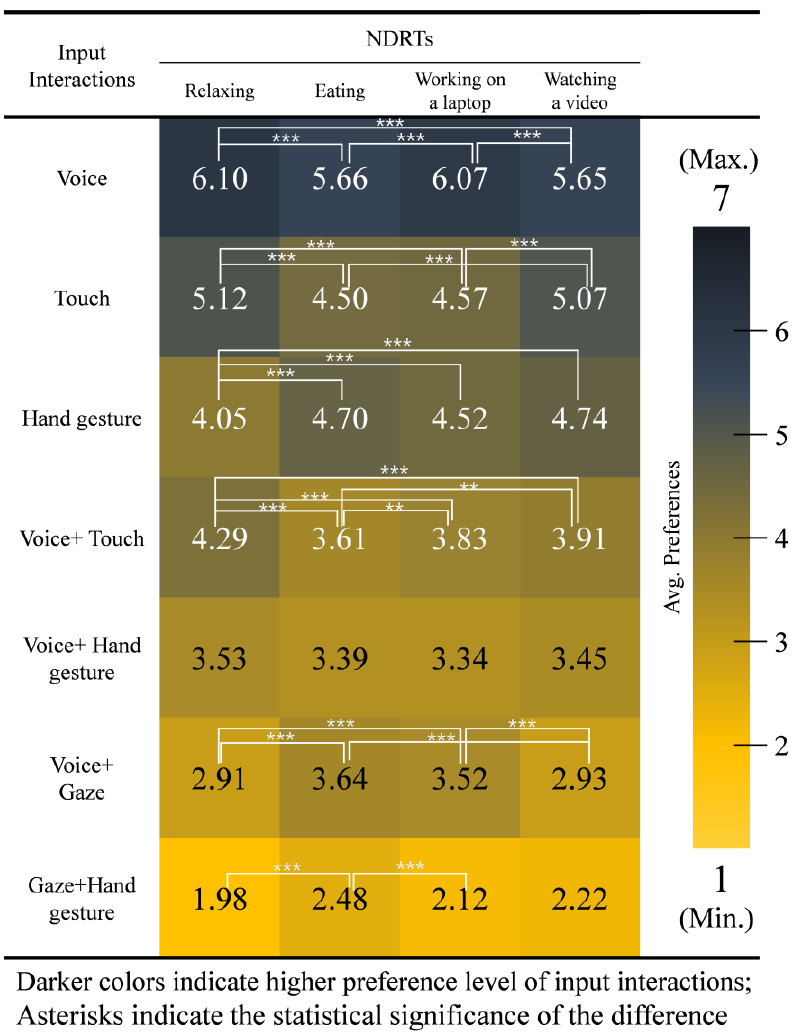
Figure 8. Preference scores for each input interaction associated with the type of NDRT.